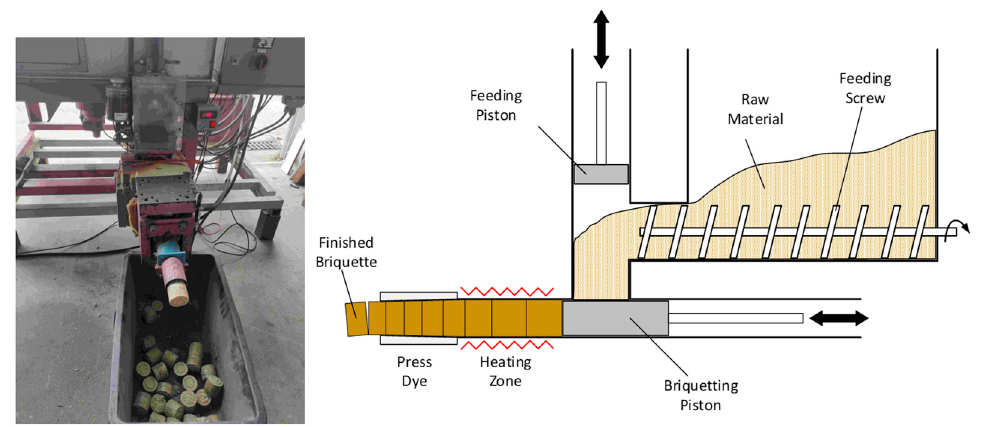
Figure 2. A hydraulic-powered biomass briquetting machine.